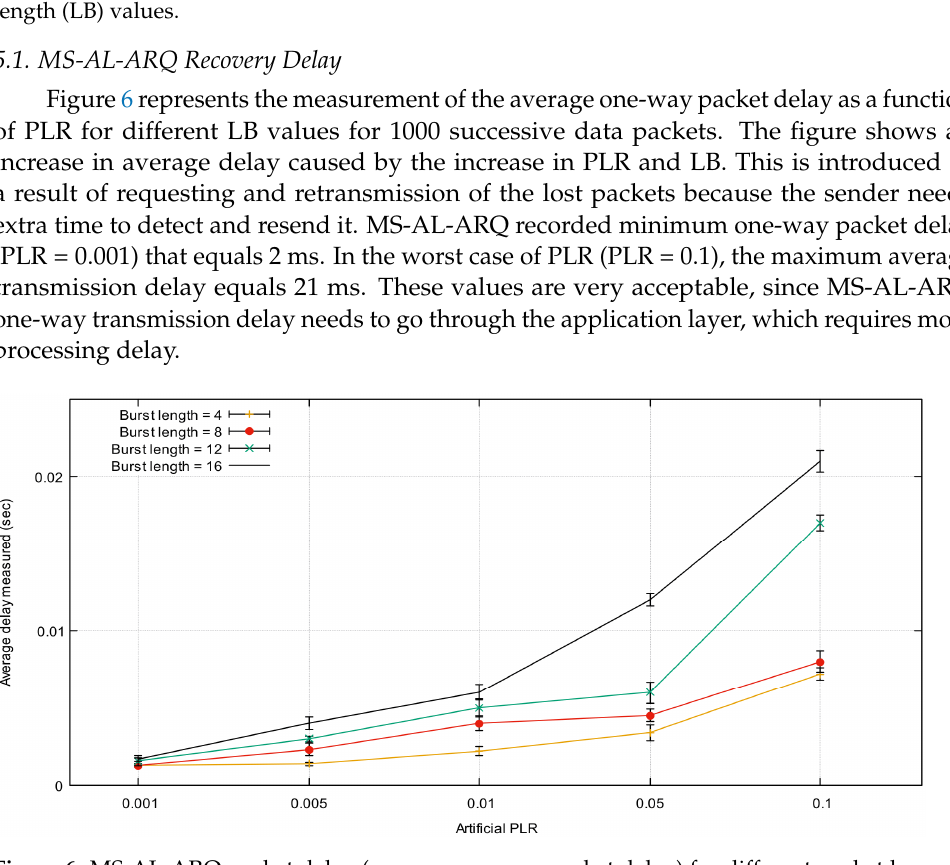
Figure 7. Average delay of retransmitted packets. Figure 8 shows the direct correlation between packet delay and jitter. If the transmis- sion is lossless, the delay and delay jitter do not increase, but if the packet loss event oc- curs, the delay will be increased by additional recovery time, which leads to an increase in delay variation (jitter). The results also show that jitter of lost packets is spread a little bit more widely, where we recorded a maximum delay jitter (the worst-case delay jitter) up to 2.5 ms, the average jitter was 0.3 ms, and maximum packet delay was up to 9 ms. Note that these results evaluate the performances of the MS-AL-ARQ algorithm in the case of a simple network that does not include any relay nodes. For further research, these metrics will be used to define the optimal values of the parameters of a dynamic jitter buffer on the relay node(s) to control the one-way packet delay between the source and the destination node.